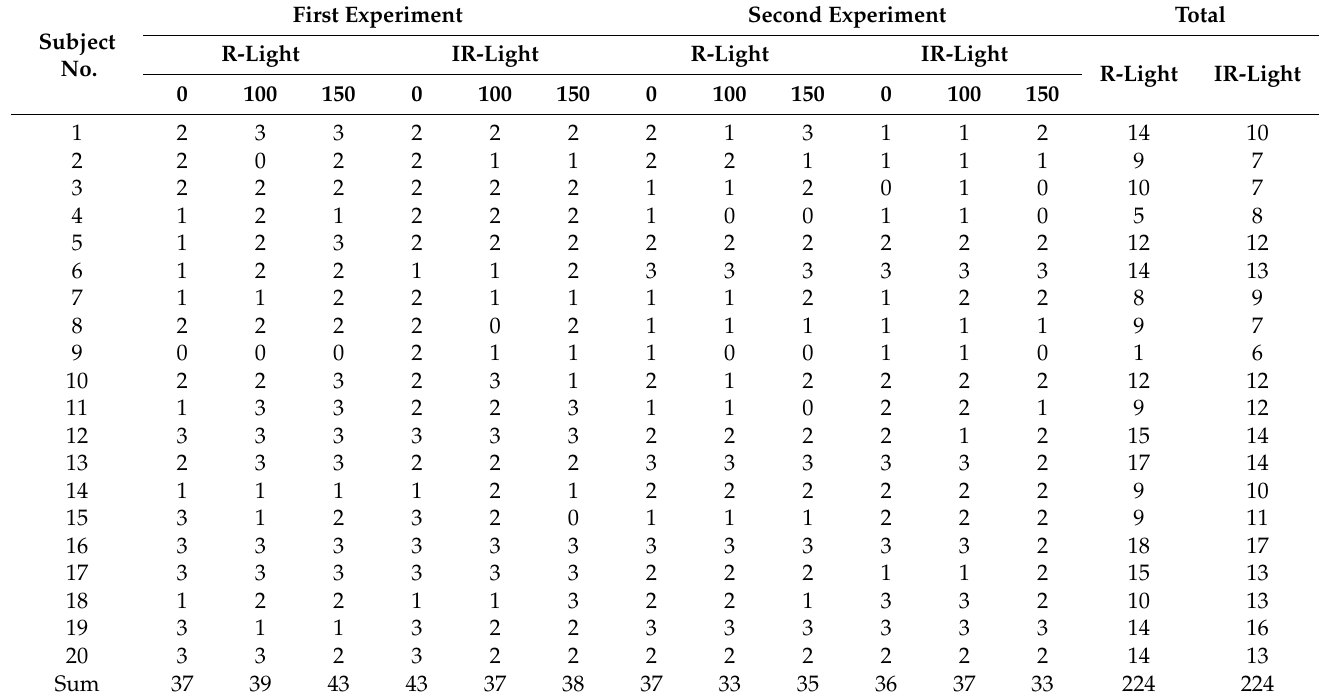
Table 1. The numbers of LRR signals with good quality for each subject.